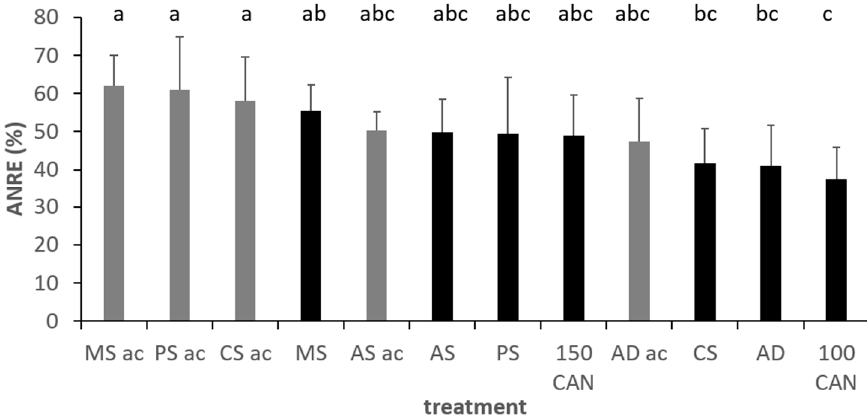
Figure 9. Apparent Nitrogen Recovery (ANRE) in the different treatments across the two winter wheat trials, Foulum, DK, grey colours indicate acidified variants. Fertilization level of applied slurries: 130 kg mineral N. Error bars depict standard deviations. Mixed effects model analysis with HSD post hoc test at p < 0.05. Lowercase letters indicate significant differences between treatments; ac, acidification; MS, mink slurry; PS, pig; A, anaerobic digestate; AS, liquid phase separated A; CS, cattle slurry; 100/150, kg N ha − 1 applied as CAN .